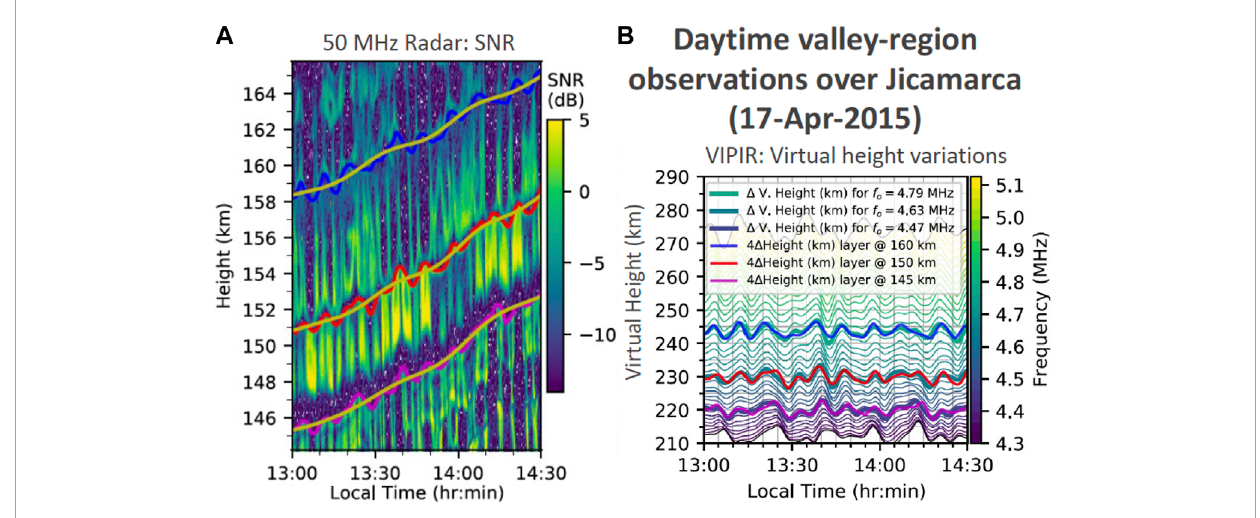
FIGURE 10 Daytime valley region observations over Jicamarca on 17-April-2015: (A) 150-km SNR with Jicamarca 50 MHz radar, and (B) VIPIR virtual height reflections. In (B) reflecting frequencies are color coded. Solid color curves magenta, red and blue show the oscillations of the wide gaps in (A) representing forbidden layers around 145, 150, and 160 km, respectively. Their corresponding fluctuations are overplotted to VIPIR virtual heights in (B) (adapted from Reyes et al., 2020, Figures 11, 13).